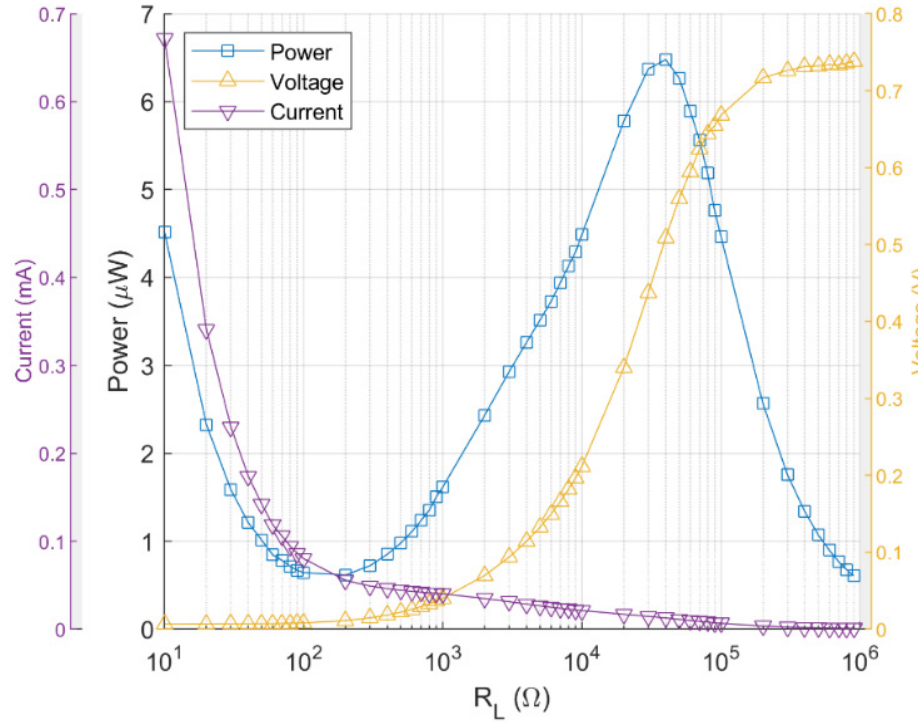
Figure 10. Power, voltage, and current depending on the load resistance value R L for PEH excited by a sinusoidal wave with an amplitude of 5 V and frequency of 20.8 Hz.